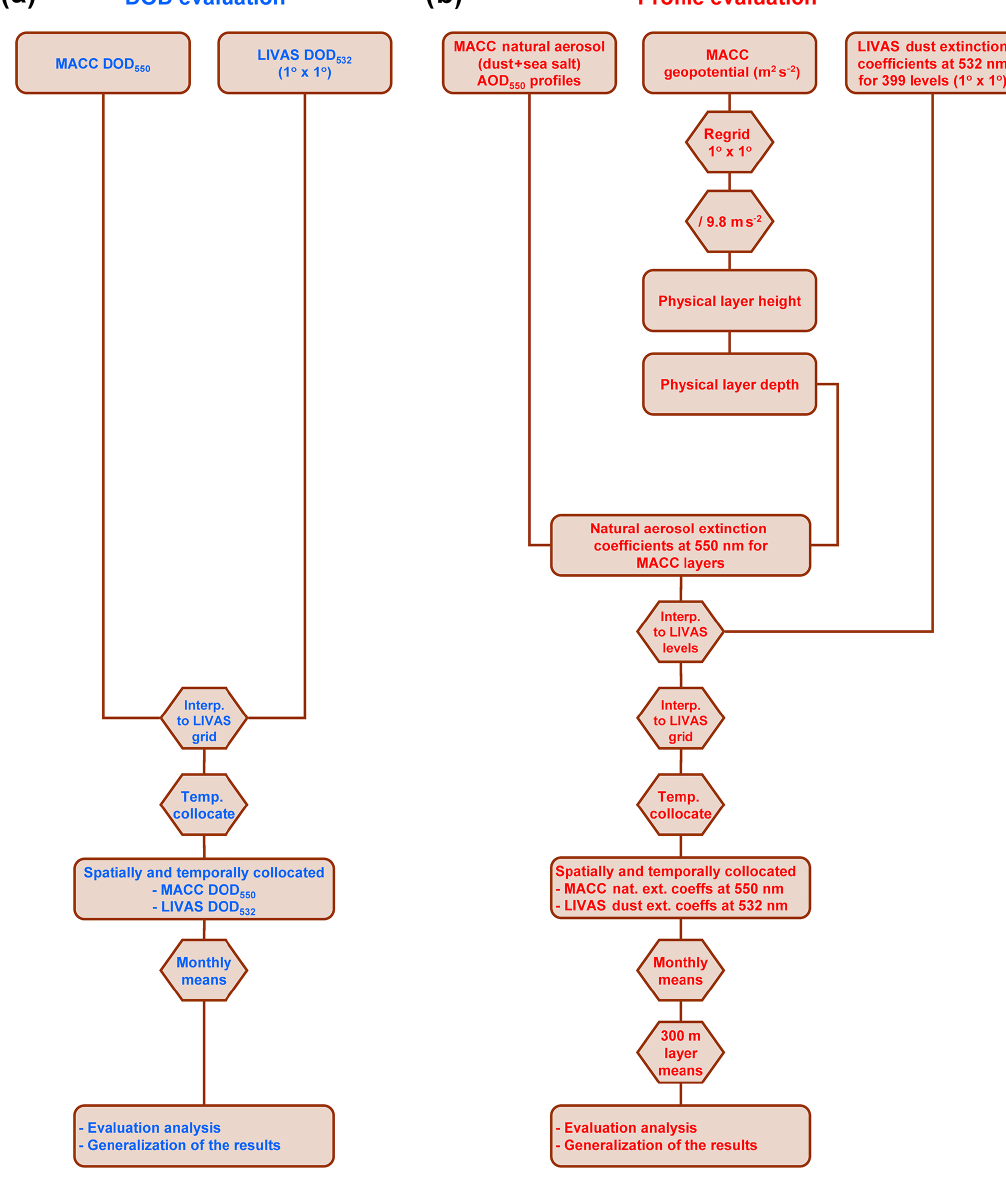
Figure 1. Flowchart with the procedure followed for the evaluation of the columnar (a) and profile (b) MACC reanalysis dust-related datasets using the LIVAS CALIOP/CALIPSO satellite-based